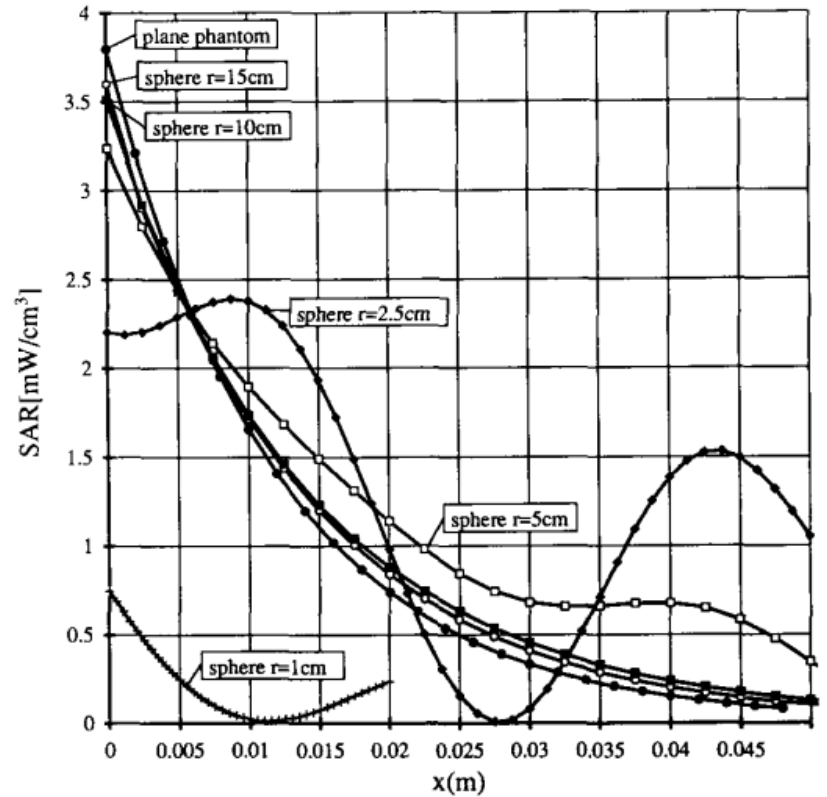
Figure 5. The absorption of the plane phantom is compared with the absorption in spheres of different radii, T, consisting of and using the same λ /2 dipole excitation (840 MHz. d = 25 mm). All values are calibrated to an antenna current of 100 mA.